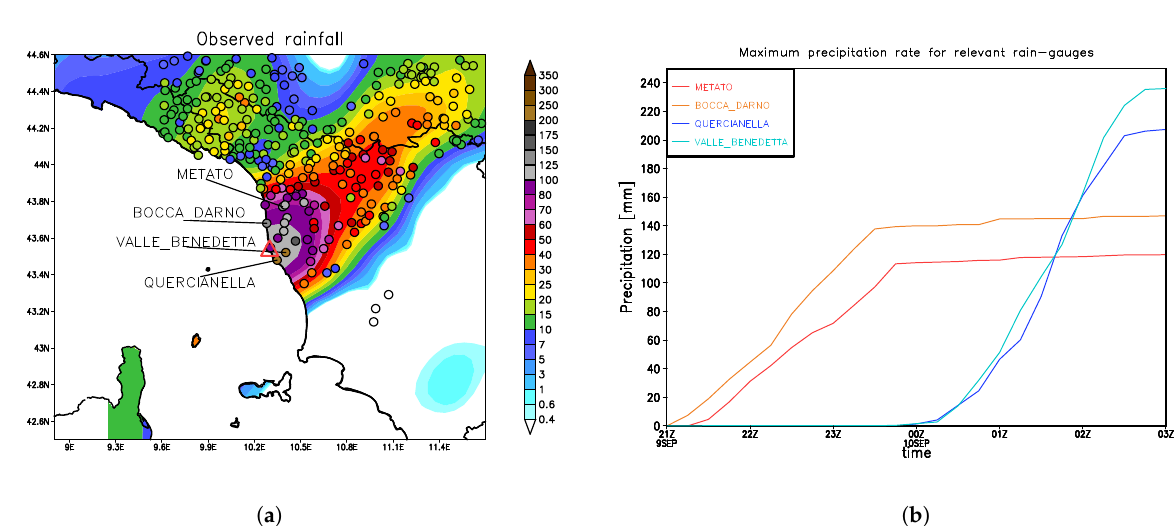
Figure 2. ( a ) Observed rainfall accumulated in the 6 h period ending on 10 September 2017 at 0300 UTC, registered by automatic weather stations in the Tuscany region and surrounding areas. The Cressman interpolation technique [56] is used to estimate rainfall amounts (shown with the shaded colors) when no rain gauge data are available. The Livorno township is indicated with the red triangle (“ (cid:52) ”). ( b ) Accumulated precipitation registered by four rain gauges located close to the Livorno township. Two of them are located to the north of the city (Metato and Bocca d’Arno) and two to the south (Valle Benedetta and